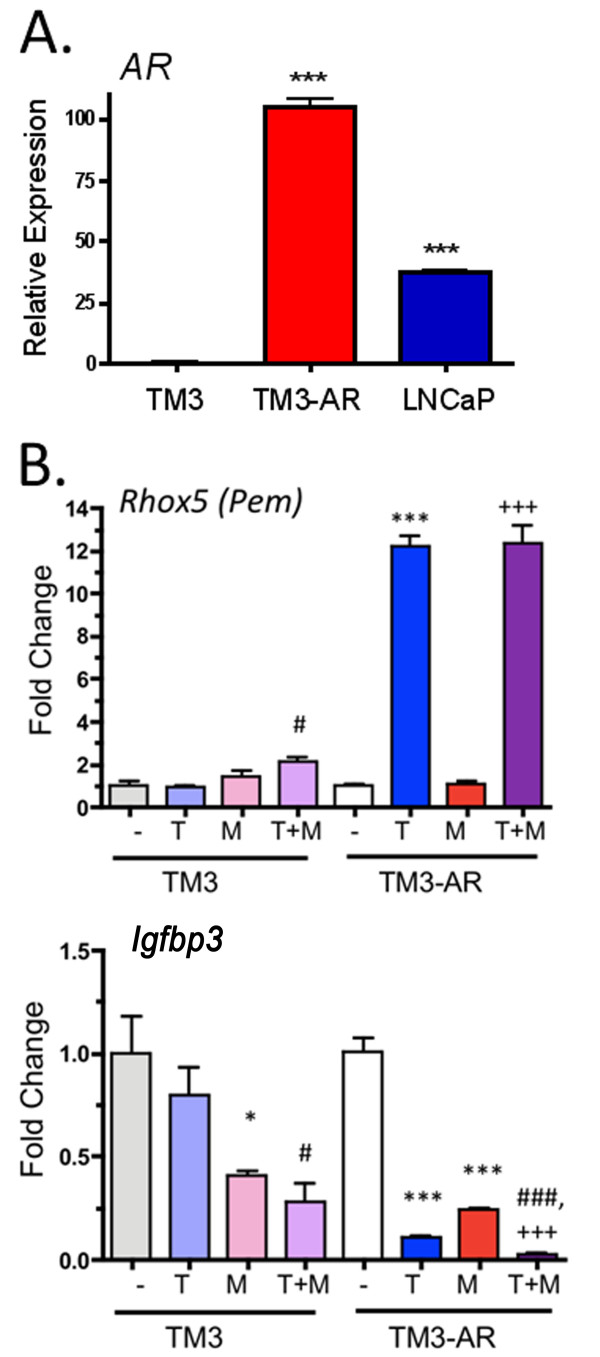
qPCR analysis of the expression of AR (A), testosterone induced gene Pem (B) and testosterone repressed gene Igfbp3 (B). In A, infection of TM3 cells with retorvirus expressing AR cDNA is shown to lead to AR expression at a level similar to that of LNCaP prostate cancer cells. Significantly different from TM3 cells at p < 0.001 (***). In B, cells were untreated (DMSO vehicle alone, -), or were treated for 24 hr with testosterone (T, 10 nM), MAA (M, 5 mM), or with T + MAA, as indicated. Rhox5 is a testosterone-inducible Sertoli cell marker gene that is also expressed at a low level in Leydig cells in vivo [56]. Igfbp3 is repressed by testosterone, and by MAA [22], with the latter response also seen in the TM3 cells deficient in AR. Data are mean ± SD values based on n = 3 replicates, with the untreated TM3 cell value set to 1.0. Significantly different from untreated control at p < 0.05 (*) or at p < 0.001 (***); significantly different from T at p < 0.05 (#) or at p < 0.001 (###); and significantly different from MAA at p < 0.001 (+++).